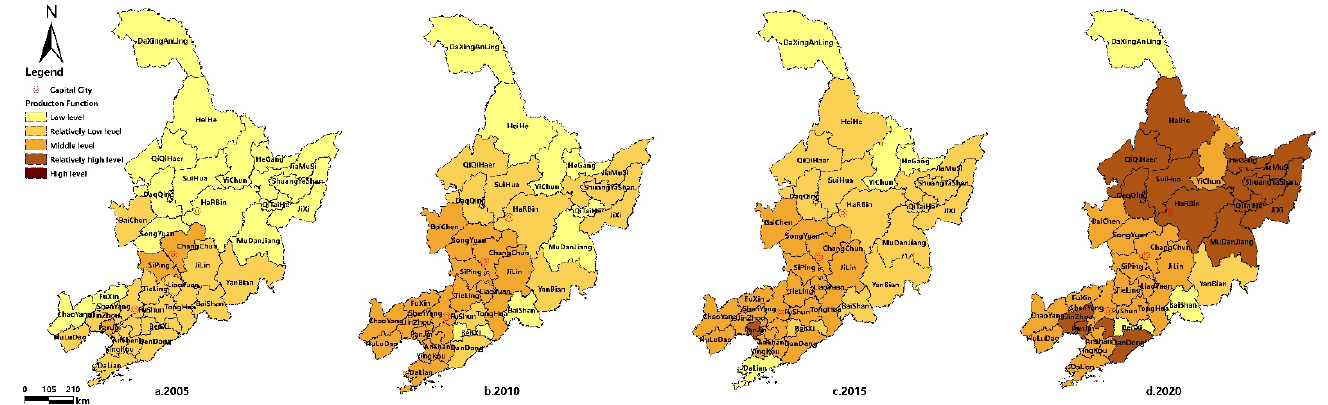
Figure 2. Spatial-temporal distribution of the production function of cultivated land in 2005, 2010, 2015, and 2020.